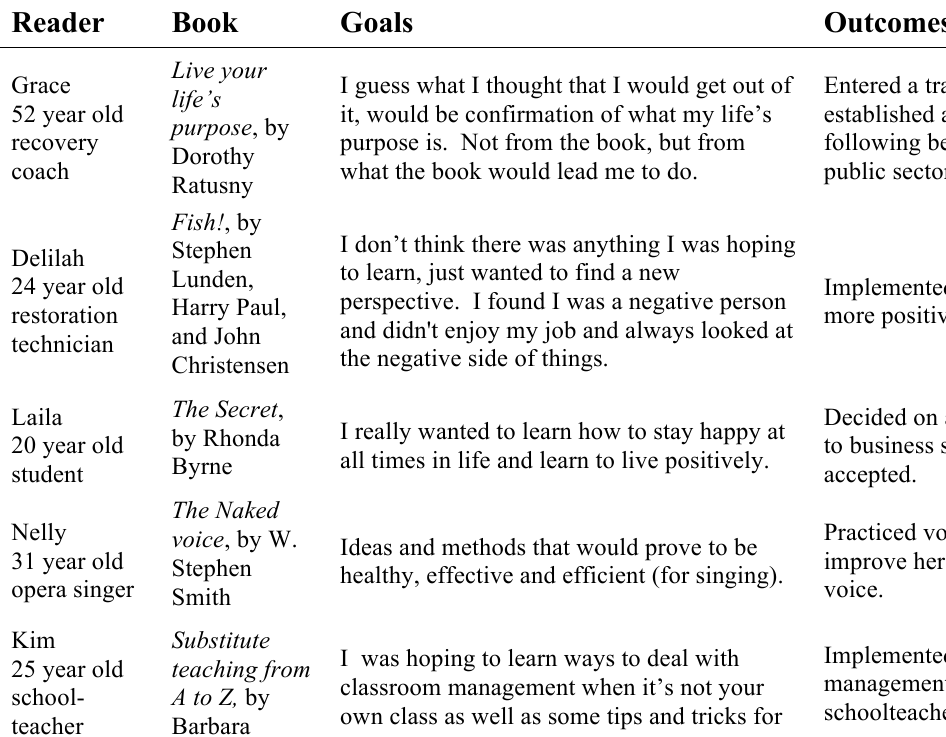
Table 4 : Female self-help reading and careers Reader